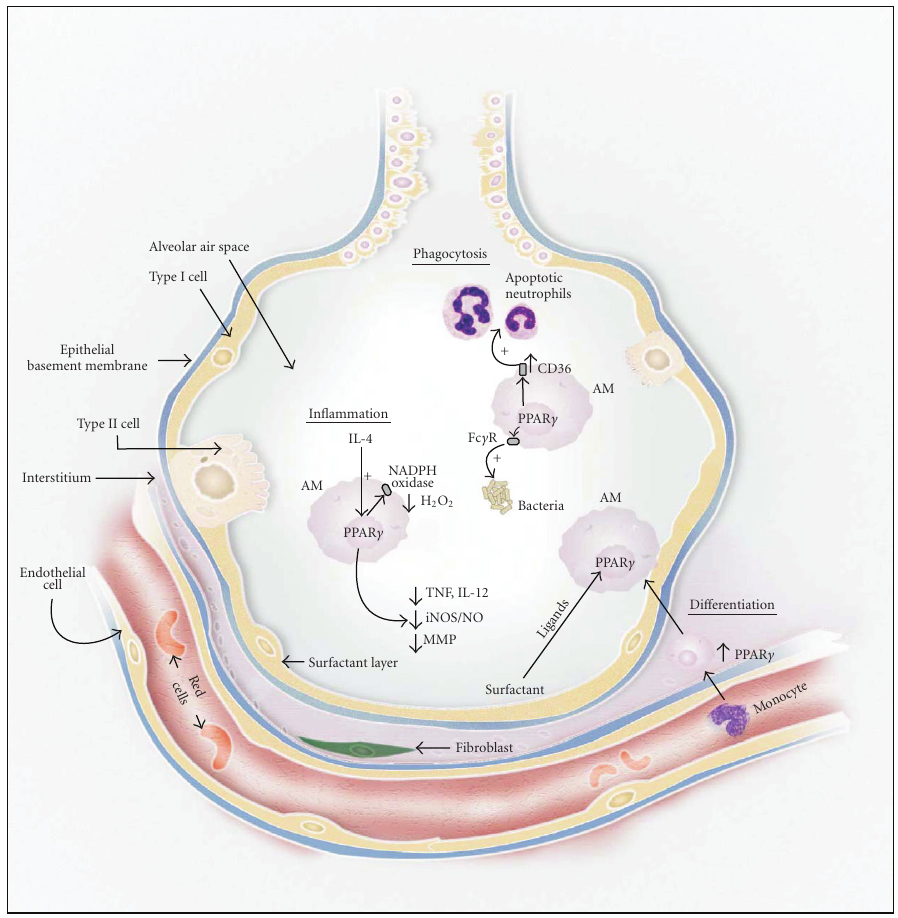
Figure 1: The alveolar macrophage: role in immunity and e ff ects of PPAR- γ . PPAR- γ promotes di ff erentiation of monocytes into AMs, then mediates e ff ects that suppress AMs’ proinflammatory activities while upregulating phagocytosis through both CD36 and Fc γ surface re- ceptors. Interaction with foreign substances causes the AM to secrete a variety of inflammatory molecules such as TNF- α , IL-12, H 2 O 2 , nitric oxide, and MMPs. This inflammatory response is suppressed, however, by the production of substances such as IL-4 that reinforce PPAR- γ activity. Alveolar surfactant also contains lipids that can stimulate PPAR- γ , resulting in suppression of AM inflammatory activ- ity. PPAR- γ activation also enhances AM phagocytosis of bacteria and apoptotic neutrophils present in the closing stages of inflammation. Thus, inflammation becomes self-limiting. Abbreviations: AM = alveolar macrophage; Fc γ R = surface receptor recognizing the Fc portion of immunoglobulin G; iNOS = inducible nitric oxide synthase; MMP = matrix